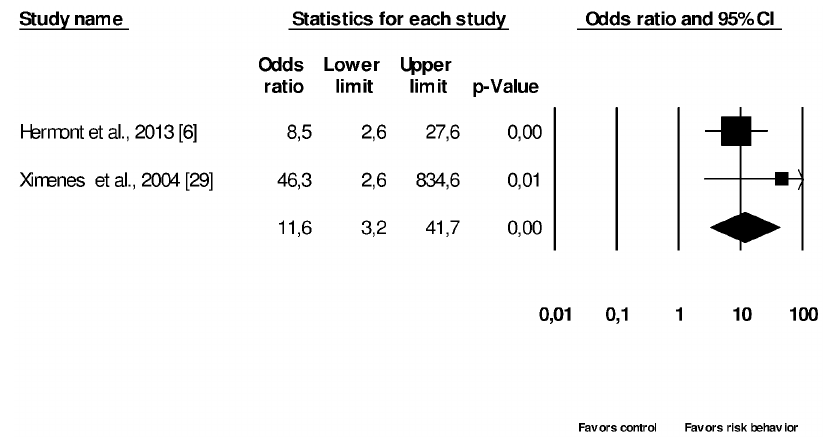
Figure 4. Meta-analysis of two cross-sectional studies associating tooth erosion with eating disorder risk behavior (EDs) vs. control groups (patients without eating disorder risk behavior), with statistical significance; I 2 =11.3%, random effect model used.